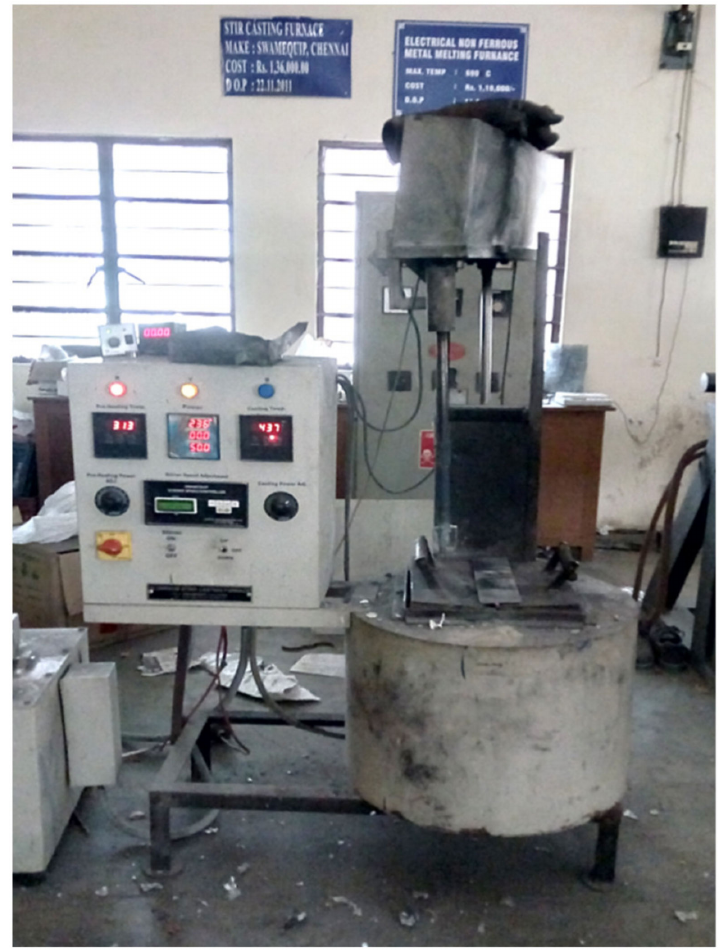
Figure 1. Stir casting